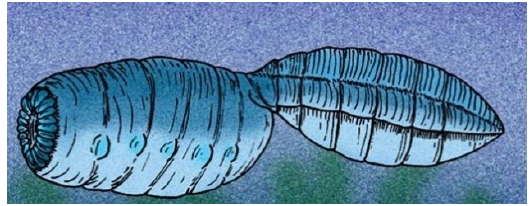
Figure 8. Didazoon haoae . PaleoArt credit: Stanton F. Fink. Used here per CC BY-SA 2.5.